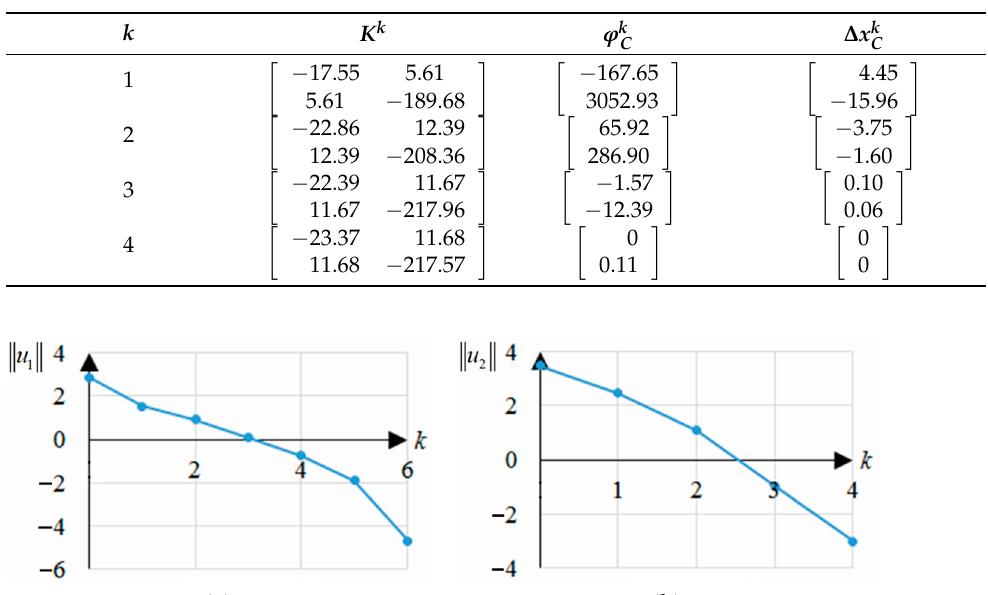
Table 4. The values of the coefficients of the system of equations, the right-hand side and the results of its solution by iterations.